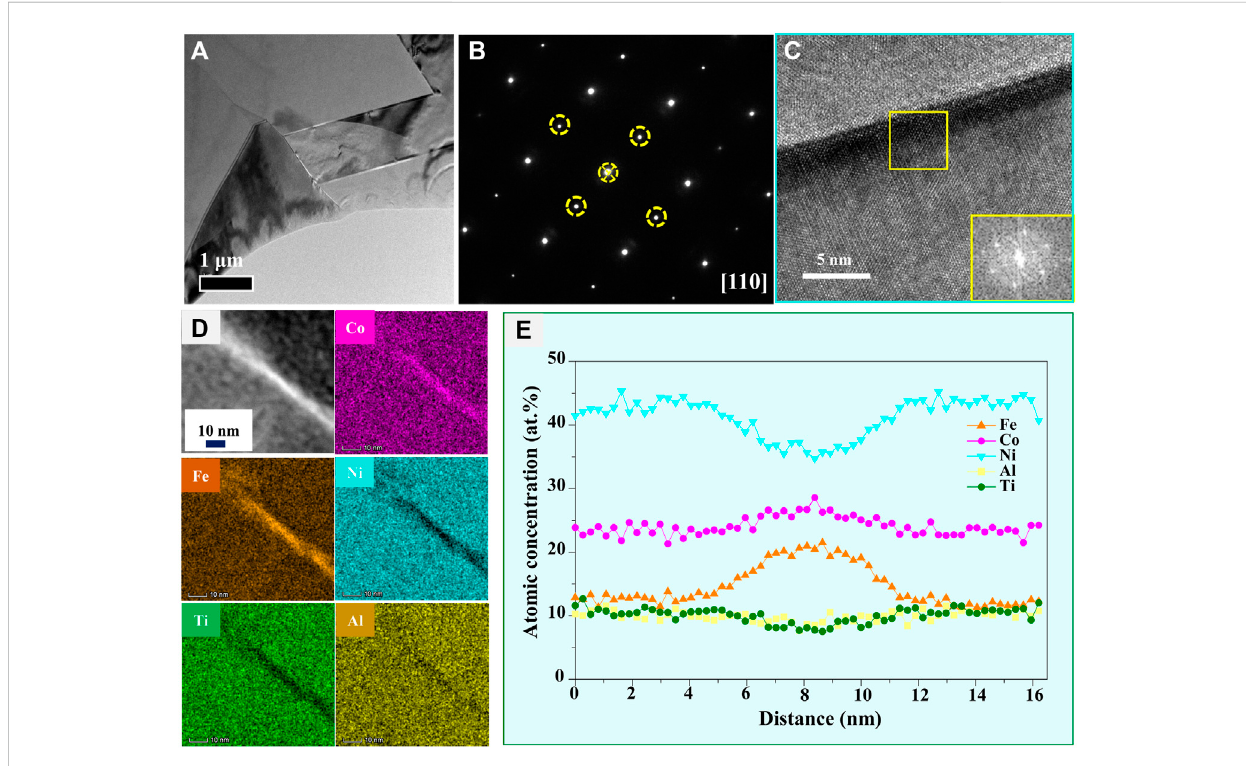
FIGURE 3 (A) Bright- fi eldTEMimage, (B) corresponding SEAD pattern,and (C) high-resolutionTEMimageoftheNi 46.5 Co 24 Fe 8 Al 12.5 Ti 9 alloy.The inset in (C) is the FFT pattern showing local disordering at the grain boundary region. (D) STEM-EDS mapping showing Fe and Co segregation at GBs and (E) corresponding compositional pro fi les across the